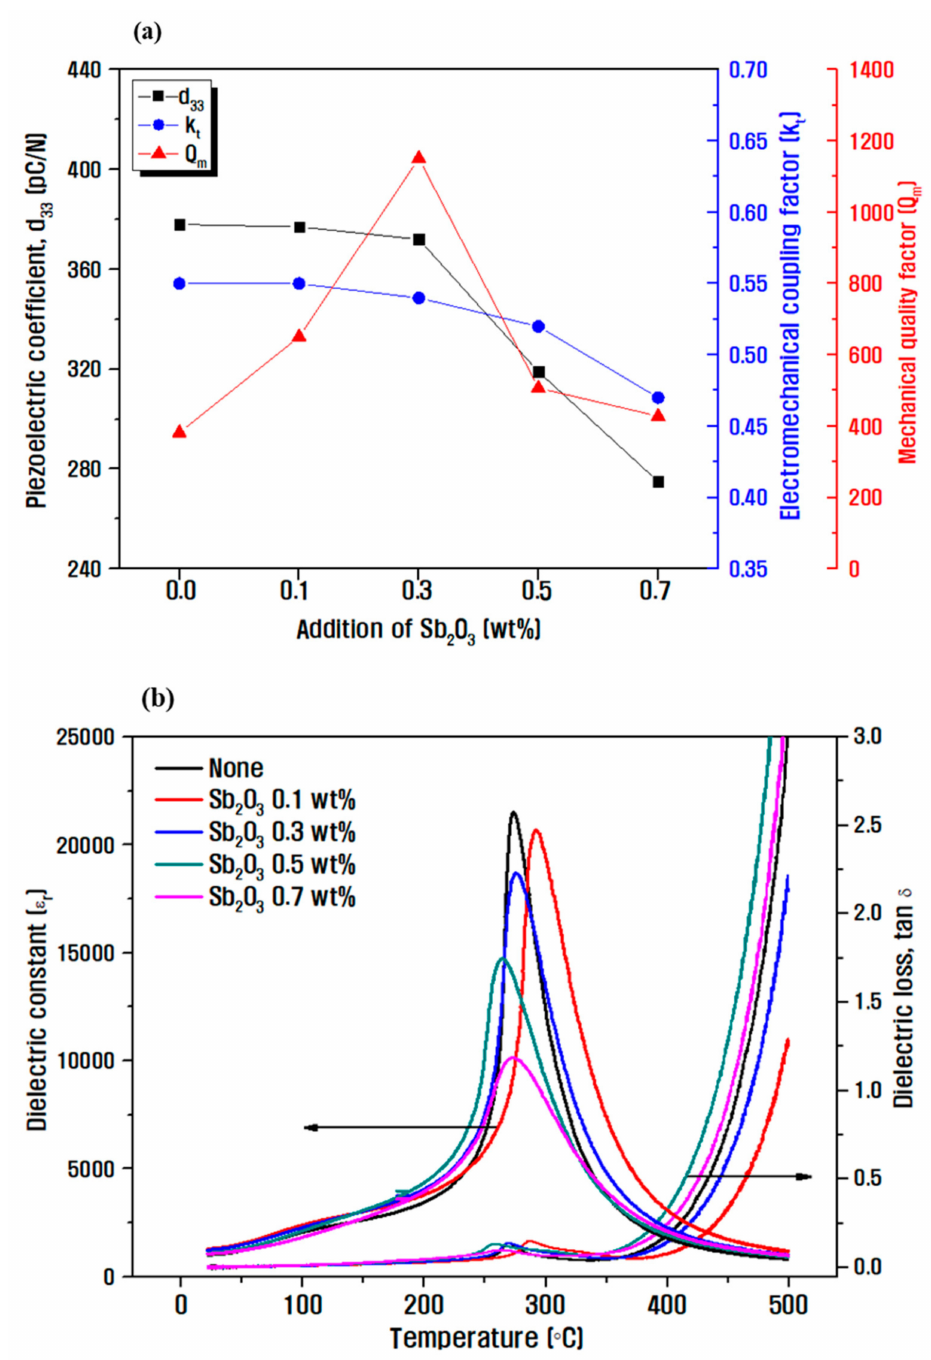
Figure 5. ( a ) Electrical characteristics of 0.08Pb(Ni 1/3 Nb 2/3 )O 3 -0.07Pb(Mn 1/3 Nb 2/3 )O 3 - 0.85Pb(Zr 0.5 Ti 0.5 )O 3 according to different Sb 2 O 3 doping amounts, and ( b ) dielectric properties according to the temperature change at 1 kHz